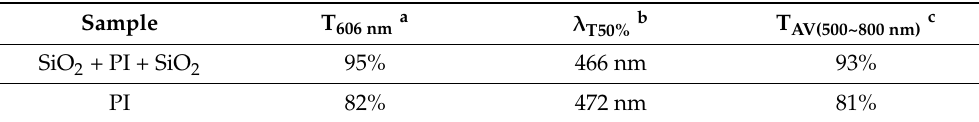
Table 1. The transmittance results of PI membrane before and after coated with SiO 2 antireflective membrane on both